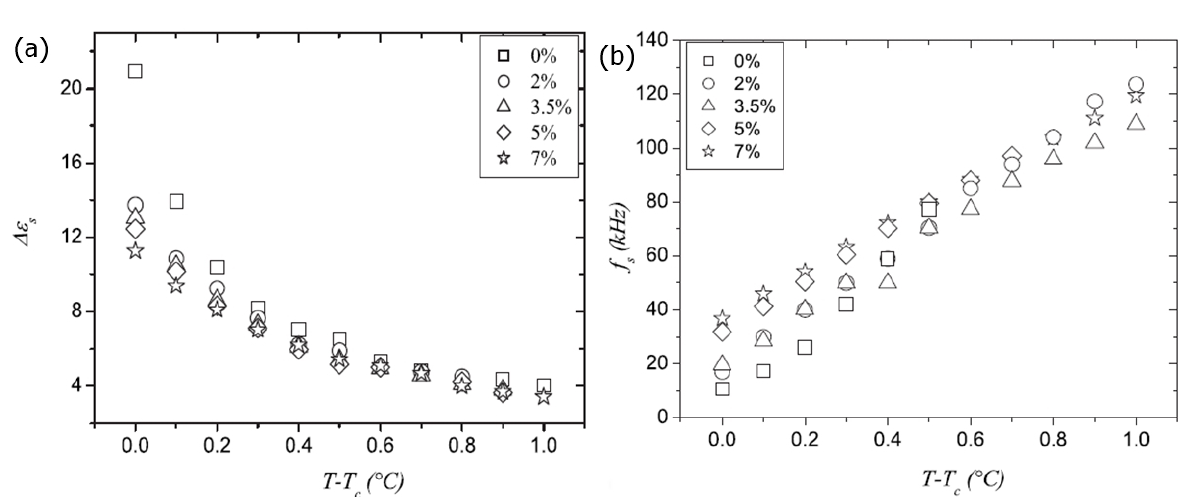
Figure 12. ( a ) Also the softmode dielectric strength is slightly suppressed for increasing polymer concentration; while ( b ) the softmode relaxation frequency slightly